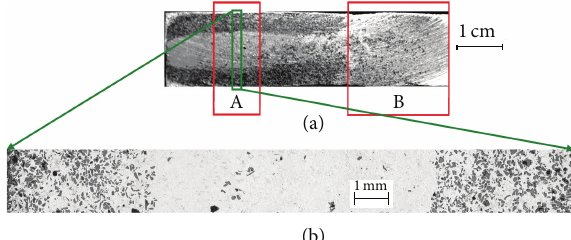
Figure 12: Macrostructure (a) and microstructure in the middle of area A (b) of the two-side reinforced disc.